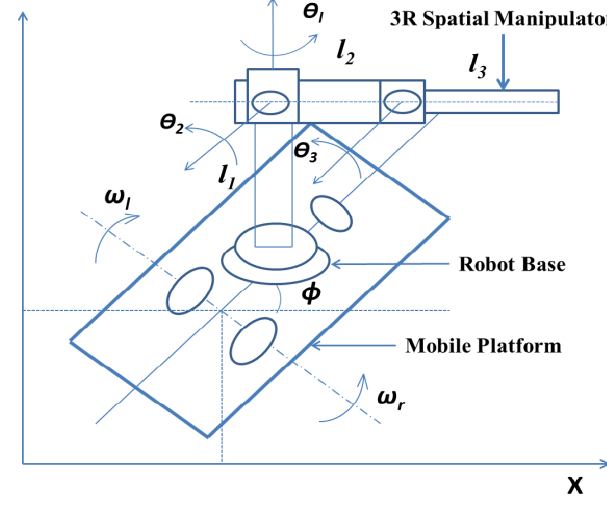
Figure 1. The kinematic model of a 3-DOF manipulator installed on the wheeled mobile robot platform and 𝜃 are rotational angles of the right and left wheel respectively. 𝜃 𝑟 𝑙 and 𝜔 are rotational velocities of the right and left wheel respectively. 𝜔 𝑟 𝑙 2b = distance between the wheel and r = radius of wheel (r = b = 1,